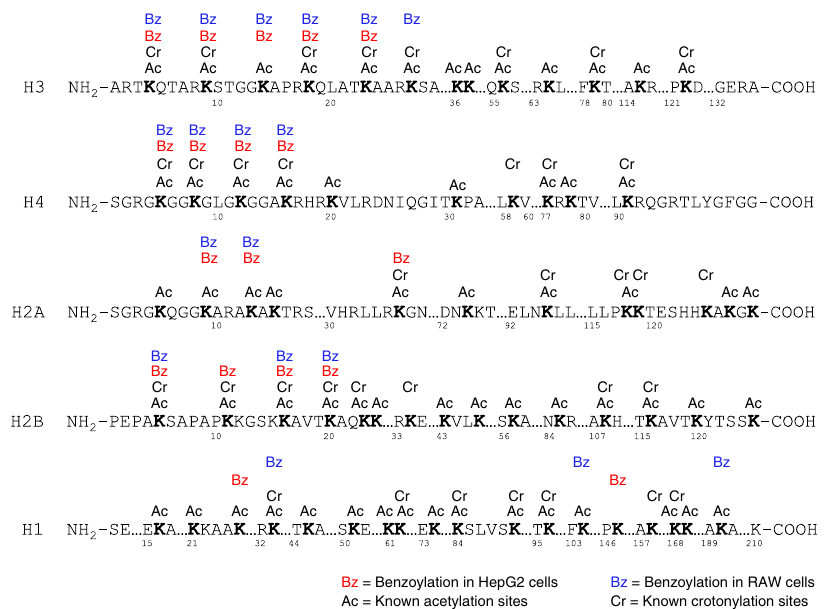
Fig. 3 Illustrations of histone K bz in mammalian cells. The detected K bz sites in HepG2 and RAW cells are shown in red and blue, respectively. For comparison, the known K ac and K cr sites described in the literature are also listed